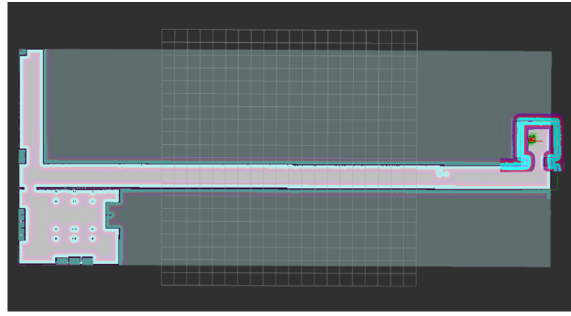
Figure 16. Reach the target